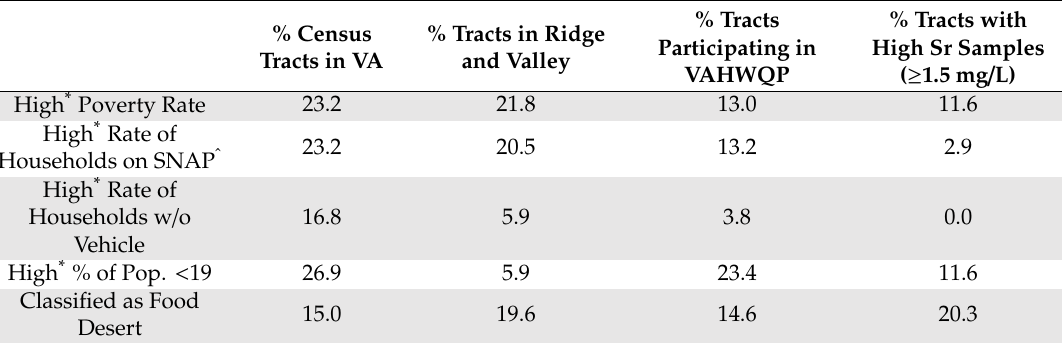
Figure 4. Food deserts by census tract. 311 Table 5. Summary of social vulnerability analysis. 312